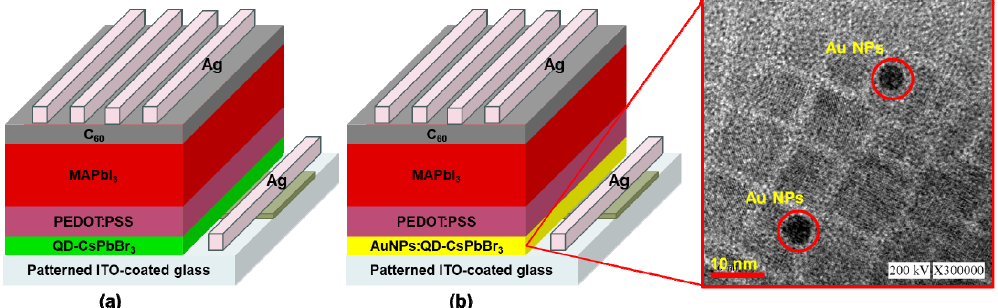
Figure 2. Schematic of the ( a ) original QD-CsPbBr 3 / MAPbI 3 and ( b ) plasmonic AuNPs:QD-CsPbBr 3 / MAPbI 3 perovskite solar cell configurations. The inset shows a TEM image of the AuNP:QD-CsPbBr 3 characterization.